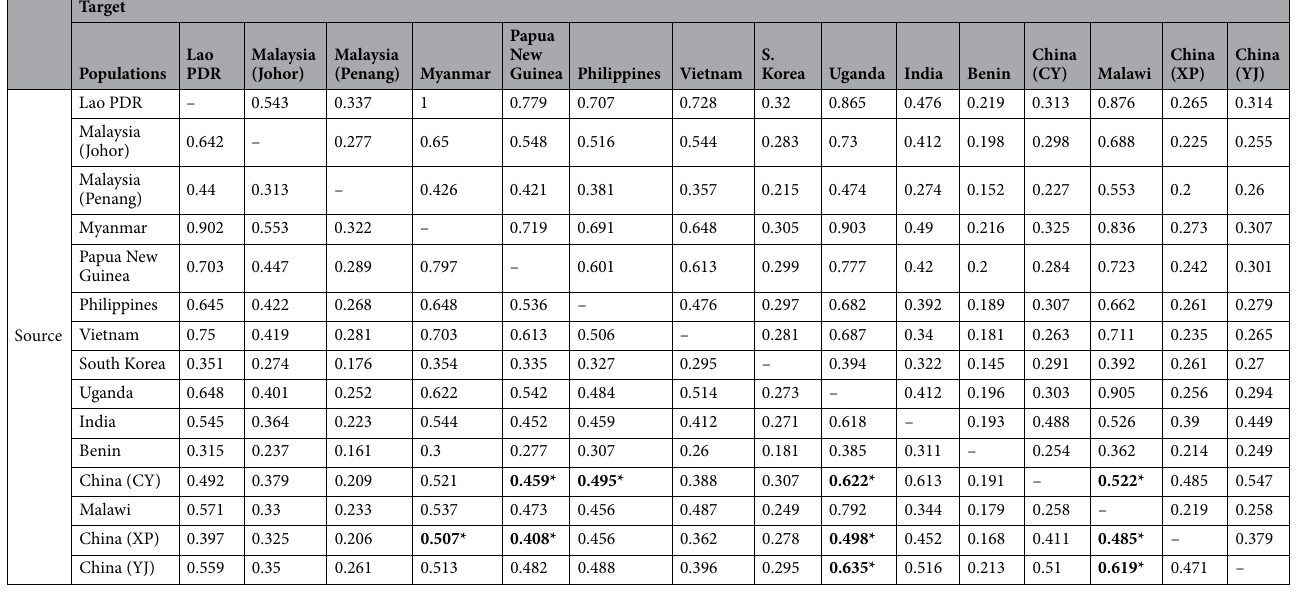
Table 3. DivMigrate matrix showing effective migration rates calculated using G ST from source to target invasive populations. Significant unidirectional migration detected from 100 bootstrap replications (at alpha = 0.5) are in bold and indicated with *. All three Chinese populations were from the Yunnan province (CY: Cangyuan, XP: Xinping, YJ: Yuanjiang). Malaysian populations are from the states of Johor and Penang as indicated in parentheses. Note: Australian populations and Malaysian Kedah populations have been excluded (see main